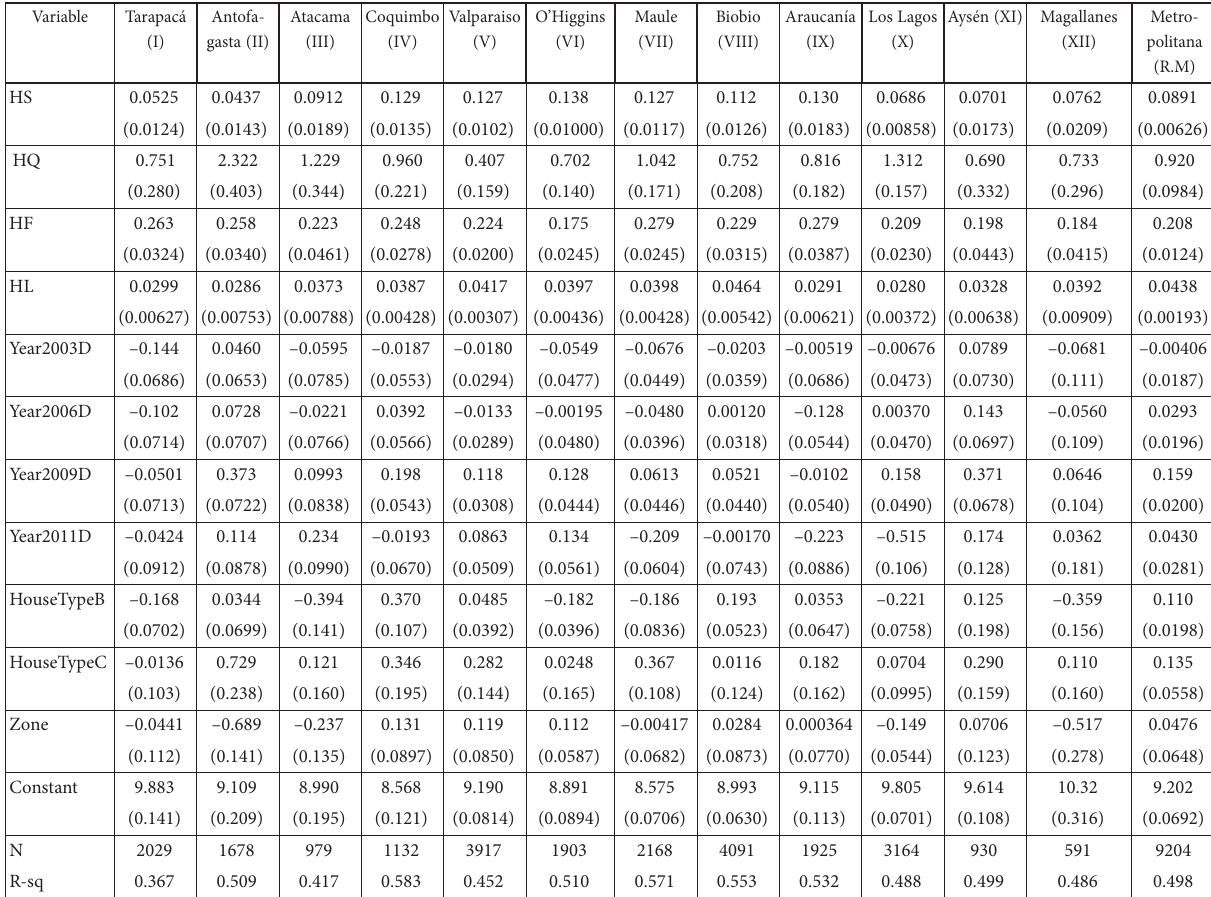
Table 2. Hedonic regression with housing feature using factorial analysis Dependent variable: log( Rent Price